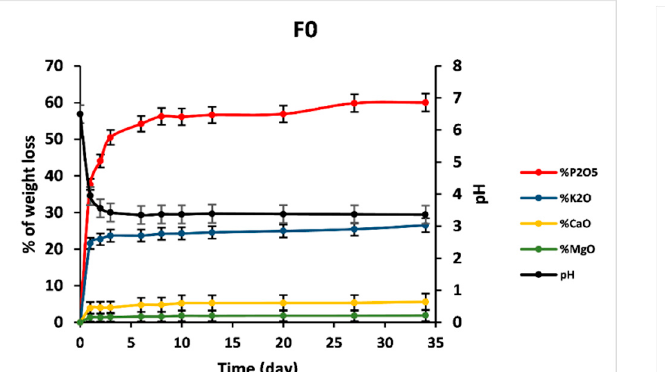
( d ) Figure 8. Percentage of glass constituents (macro-elements) analyzed in the leachate solutions (elements in the form of oxides) normalized to the initial glass weight and pH measurements versus time for ( a ) F 0 , ( b ) F 1 , ( c ) F 2, and ( d ) F 3. ( a )